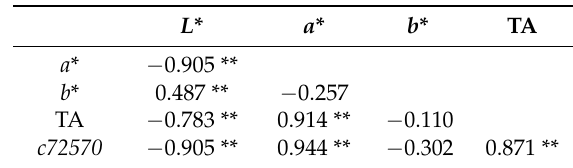
Table 3. Correlations between measurements of color, total anthocyanin content, and gene expression of variety L of Ranunculus asiaticus L.